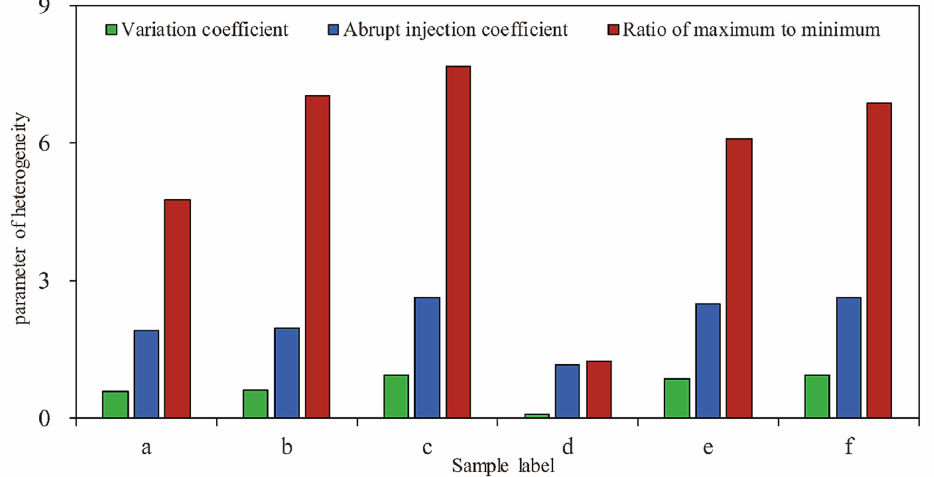
Figure 8. Variability coefficient, penetration coefficient, and gradient statistics of two-dimensional permeability of samples a–f.